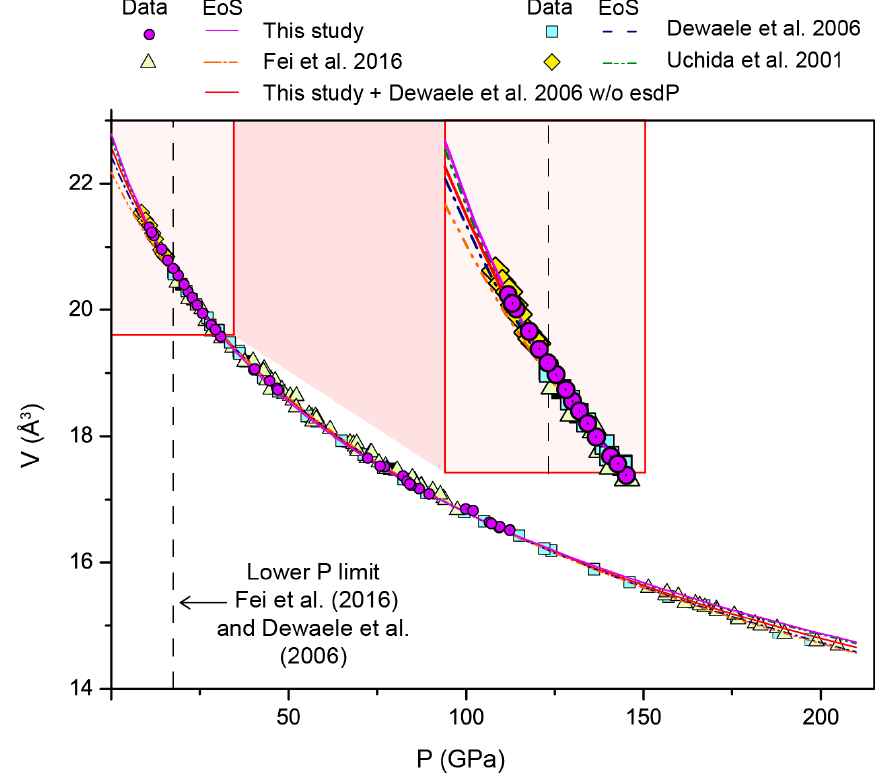
Figure 2. Compression data at room temperature with the fitted equations of state. Symbols represent the experimental points from different studies; lines are the fitted equations of state. The error bars on the data from the present study are within the dimension of the symbol. Relative to the present study, purple lines represent the equation of state obtained accounting for the errors on pressure, volume and temperature. The red line instead stands for the EoS obtained when the errors in pressure are not taken in account .